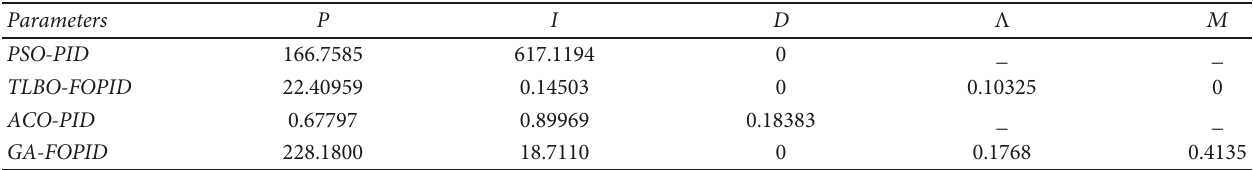
Table 2: Controller parameters of the i